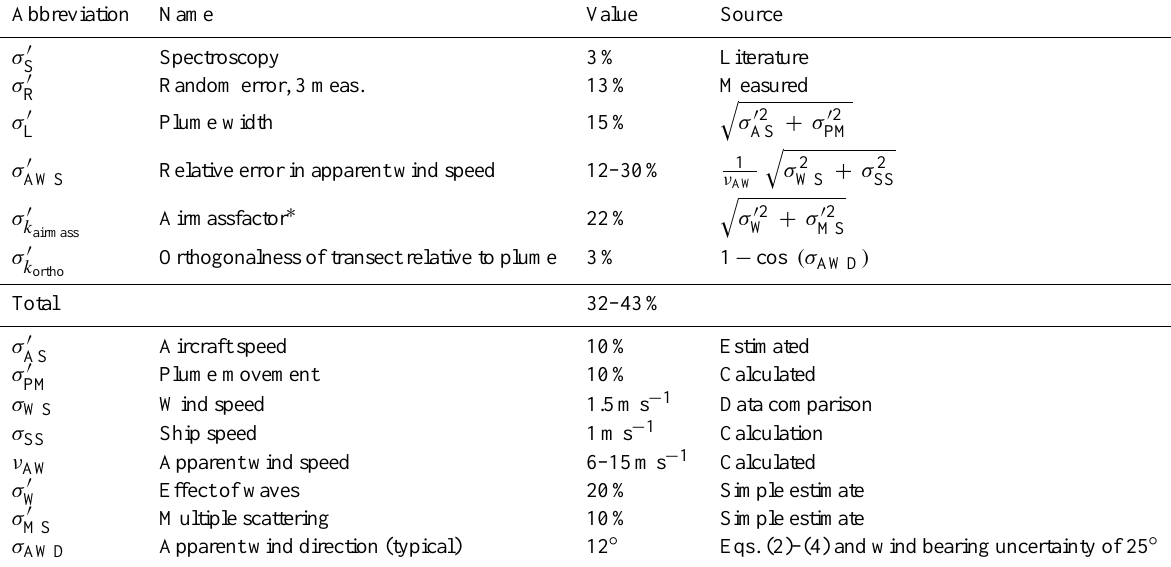
Table 5. Tentative uncertainty budget for the optical emission measurement of a single ship. The shaded area corresponds to the main errors.